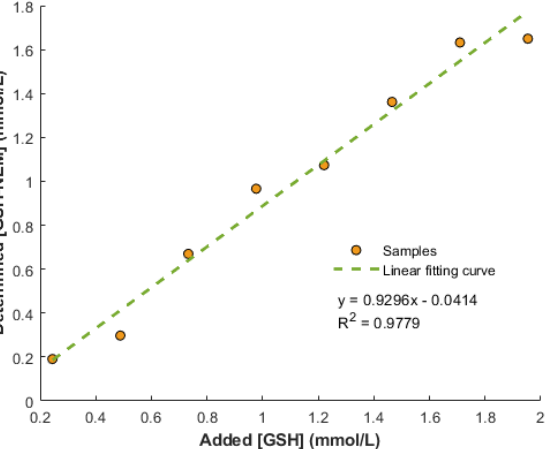
Figure 2. Experimentally determined GSH-NEM concentrations on DBS paper cards pre-soaked with NEM versus theoretical GSH concentrations of standard solutions.